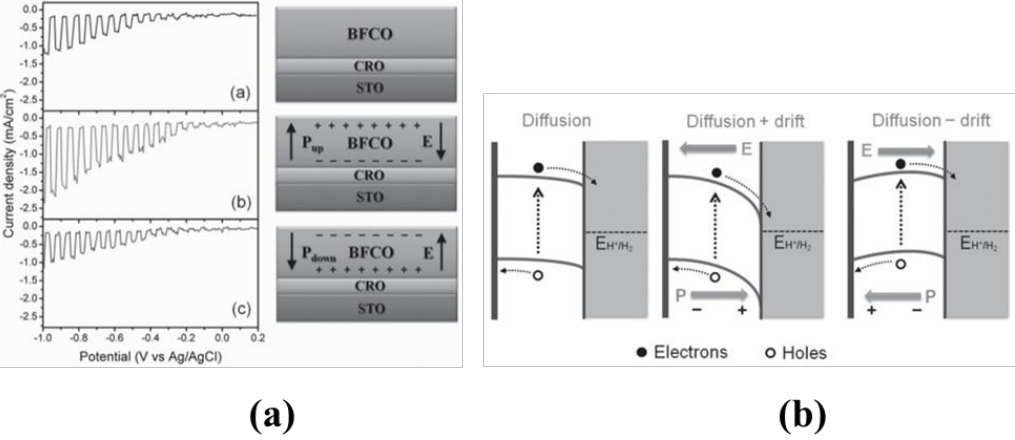
Figure 8. ( a ) Variations of the current density with applied voltage and ( b ) Simplified energy band diagrams of the PEC cell based on Bi 2 FeCrO 6 (BFCO) thin film without polarization (left) and either negatively poled (middle) or positively poled (right) [105]. Copyright 2015, Wiley Online Library.